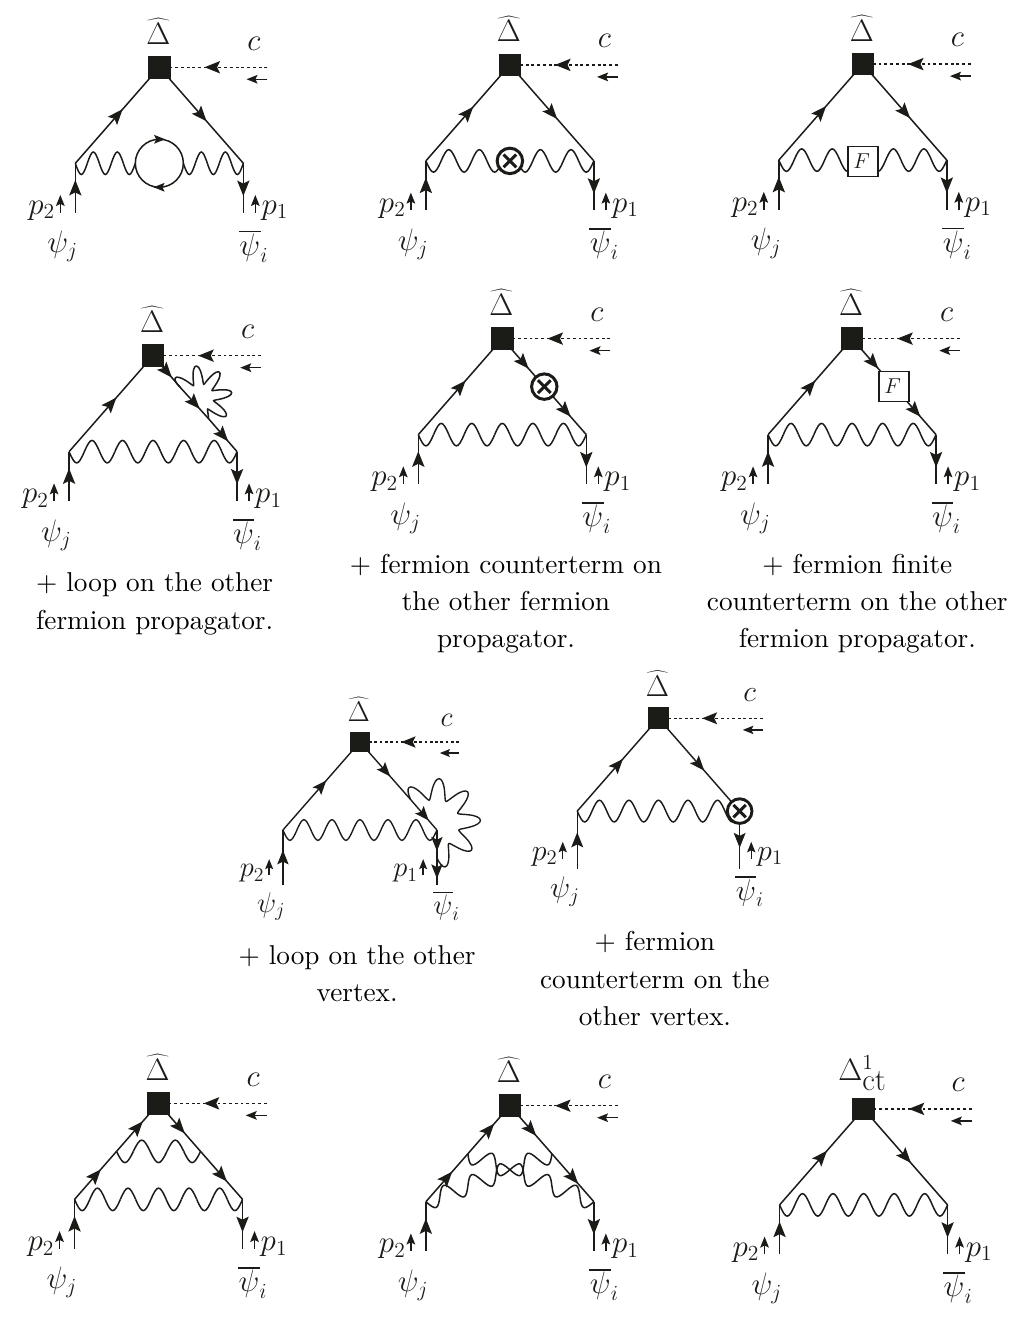
Figure 3 . List of Feynman diagrams for the Ghost-fermion-fermion breaking contribution. The symbols are as in figure 2 and the results are given in eq.